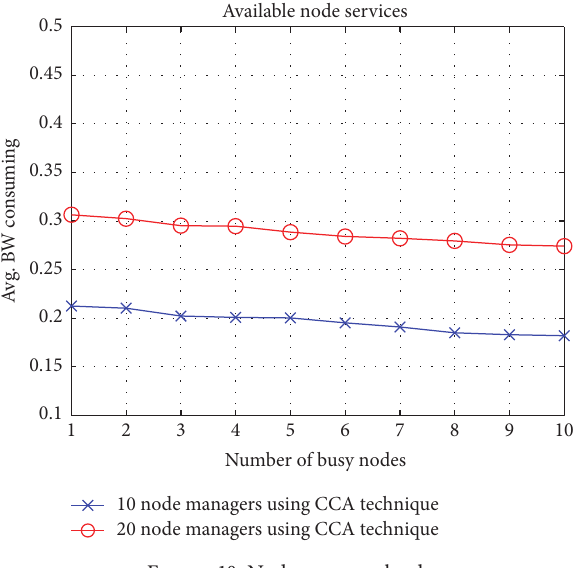
Figure 10: Node manager